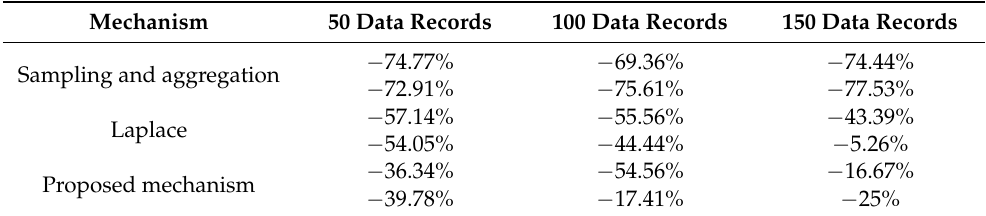
Table 2. RMSE degradation rates corresponding to linear and nonlinear query functions for different subset